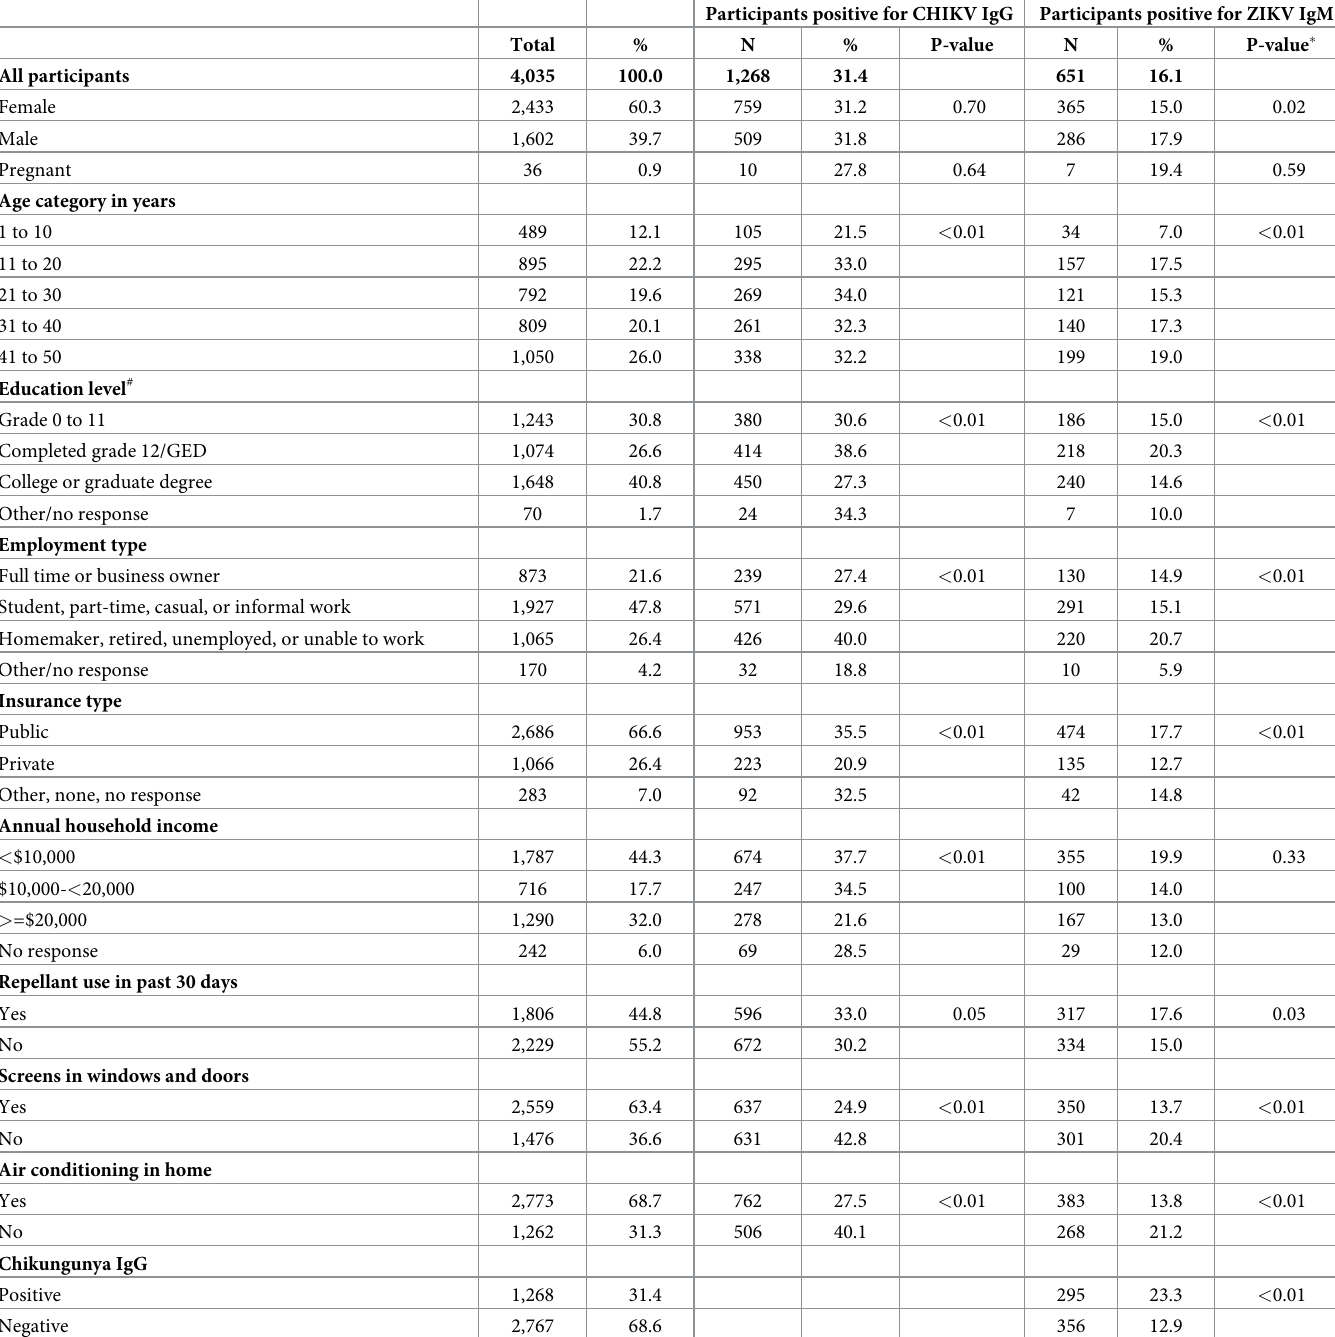
Table 1. Chikungunya (CHIKV) IgG and Zika (ZIKV) IgM results by demographic characteristics for COPA participants. Columns show descriptive characteristics of all participants, as well as the percent of each group with positive results for CHIKV IgG or ZIKV